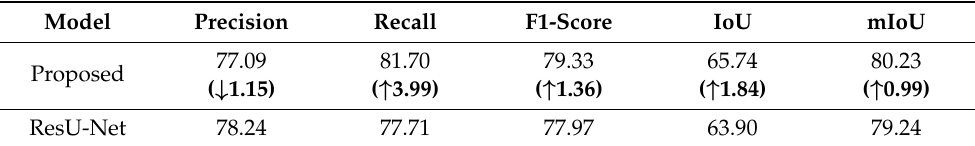
Table 3. Performance of models on the Bijie dataset. The bold means the variation between the proposed model and ResU-Net. Model Precision Recall F1-Score IoU mIoU 87.24 88.23 87.73 78.15 Proposed ResU-Net 86.85